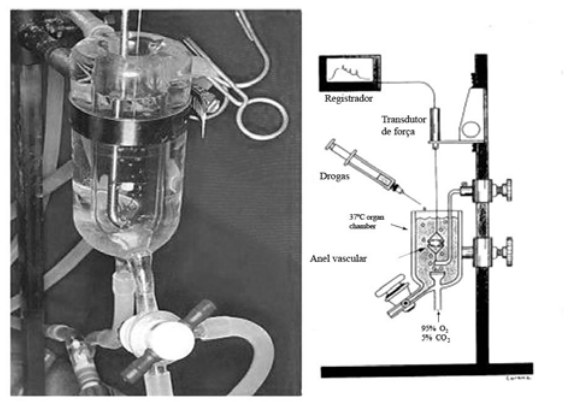
Fig. 2 - Detalhe de uma “organ chamber” isolada e sua representação